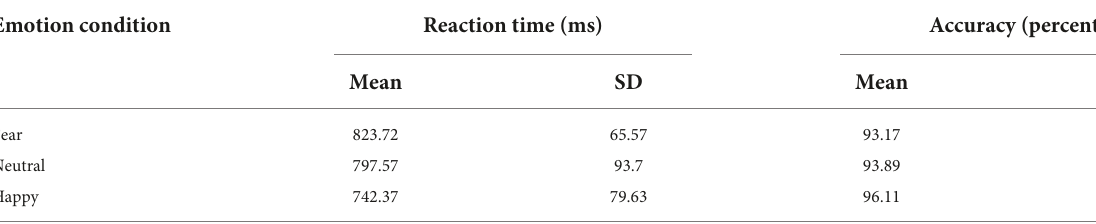
TABLE 2 Descriptive RT and accuracy values from Experiment 2.